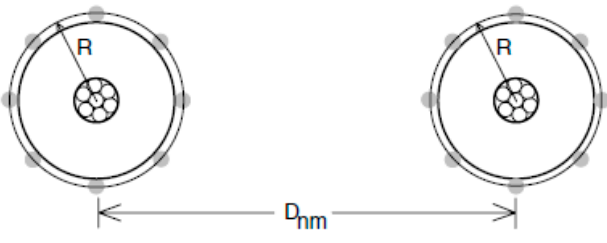
Figure A2. Distance between concentric neutral cables.